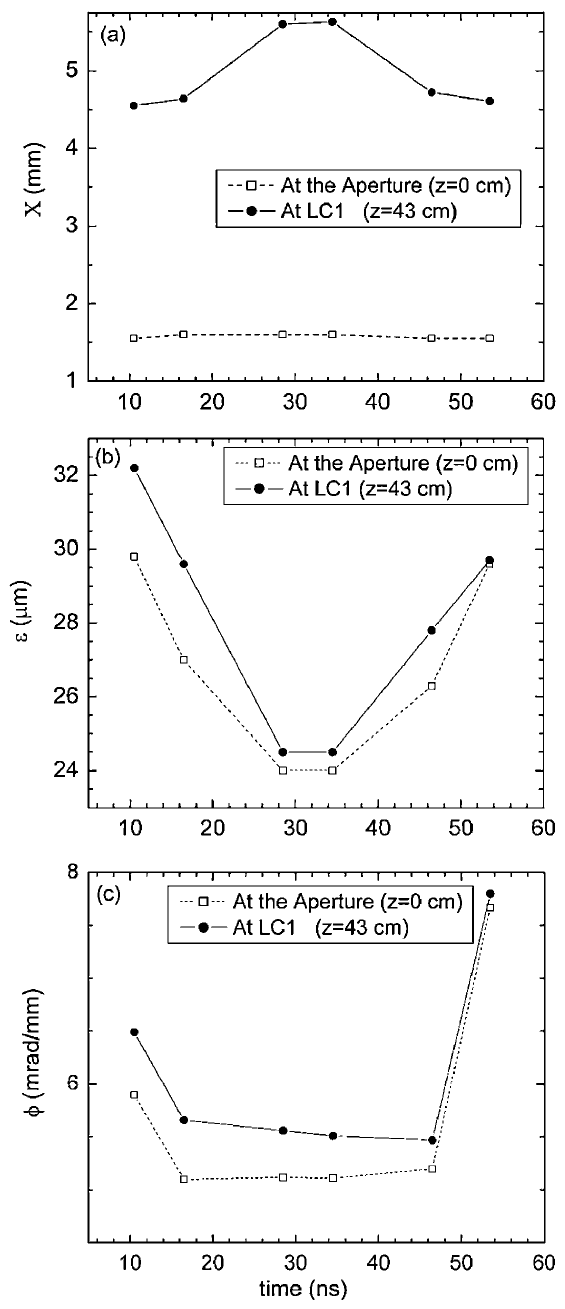
FIG. 8. Beam parameters measured in the experiment as a function of time along the pulse, at the screen location: (a) Beam size; (b) emittance; (c) slope of the phase space [from Eq. (10)]. The solid line corresponds to measurements at LC1 ( z ¼ 43 : 0 cm ) and the dashed line at the aperture ( z ¼ 0 cm